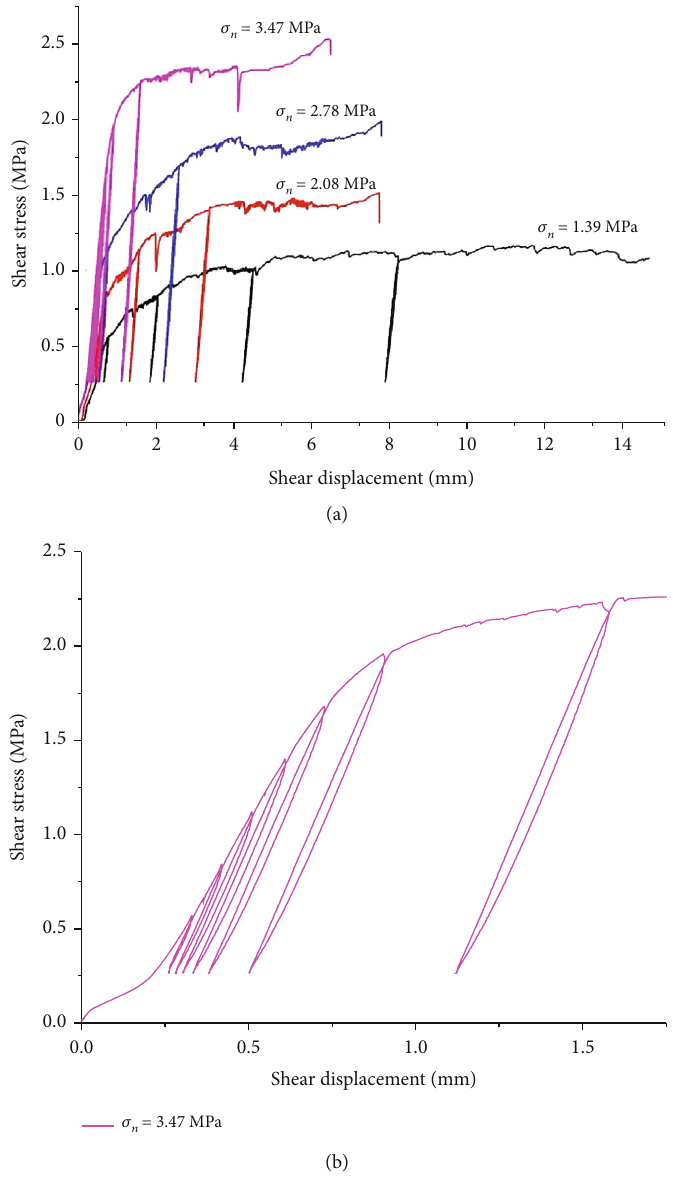
Figure 6: Shear stress versus shear displacement curves. (a) Cyclic shear behaviors of rock joints with constant normal stress of 1.39MPa, 2.08MPa, 2.78MPa, and 3.47MPa; (b) partial enlarged view of curve with a constant normal stress of 3.47MPa. Table 1: Shear strength parameters under di ff erent normal force